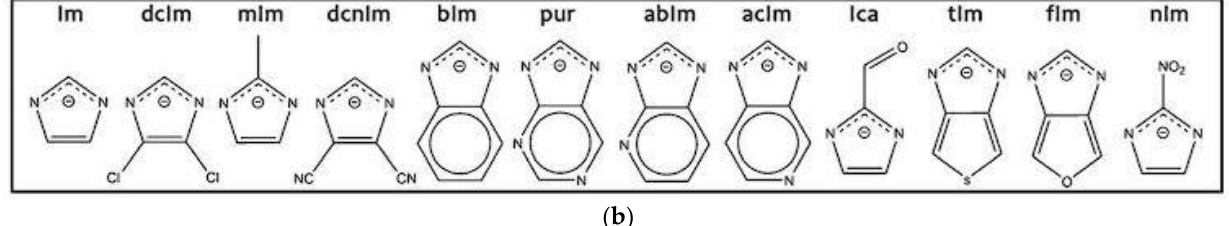
Figure 5. ( a ) The unit cell and crystal structure of ZIF [23], (Reproduced with Permission from Elsevier) and ( b ) common structure of linkers used to synthesise ZIFs. [21] [An open access Creative Commons CC BY 4.0 license].